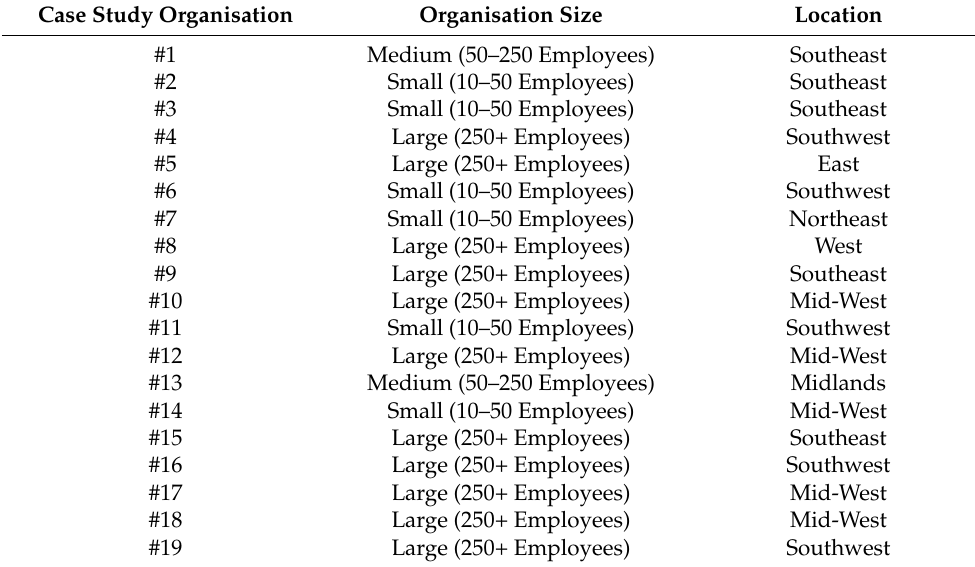
Table 2. Lean Case Study Organisations reviewed from the Irish MedTech Industry (location and size) (author